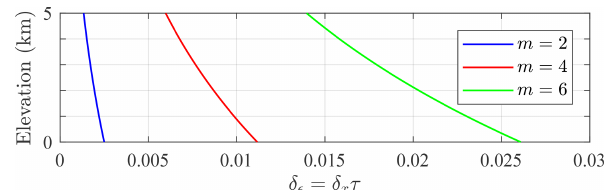
Figure 12. Assessment of stellar-magnitude errors associated with air mass miscalculation errors due to a time delay error ( δ t ) of 30s in a Rayleigh scattering atmosphere and as a function of the hypo- thetical elevation of a starphotometer site.